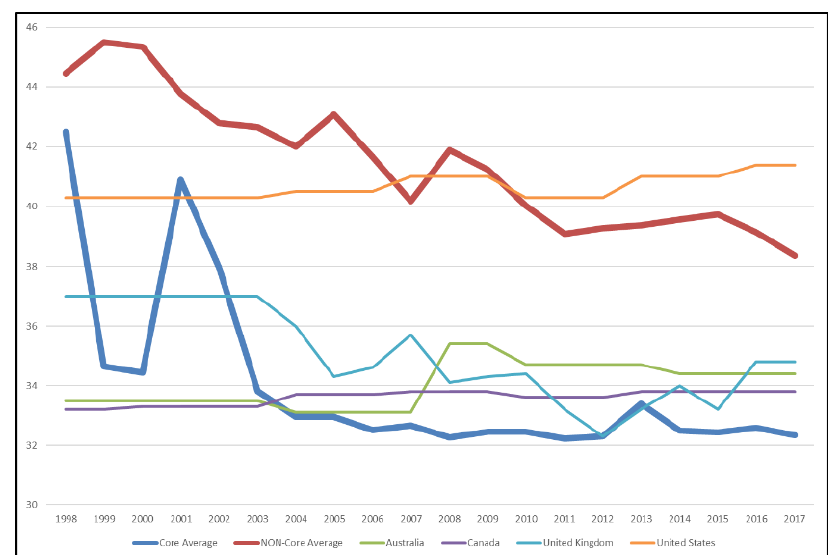
Figure 3: Gini Across the